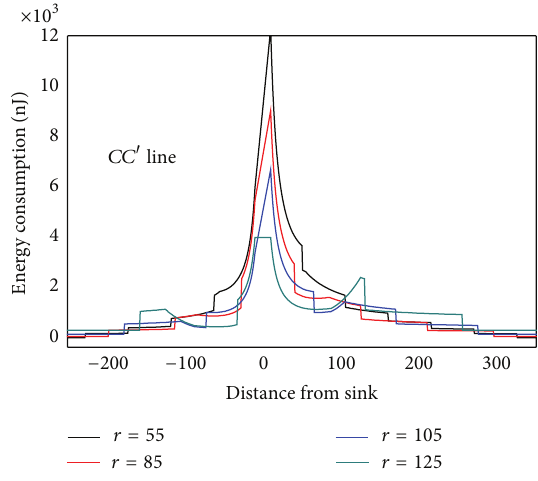
Figure 9: Energy consumption under different communication